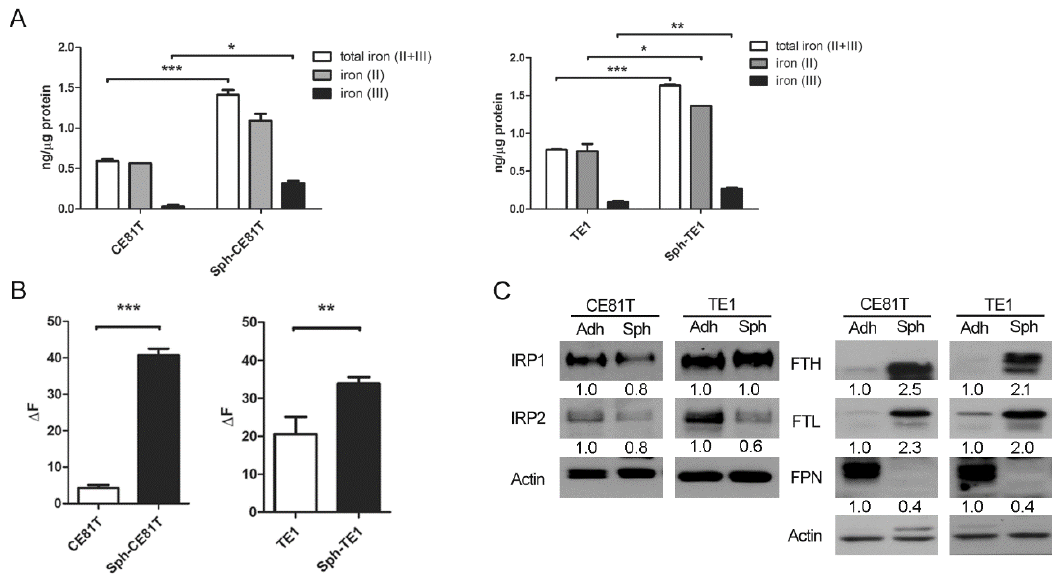
Figure 1. Esophageal cancer cells in spheroid culture have h iron content. ( A ) Total iron assay of esophageal squamous cell carcinoma (ESCC) cells lines, CE81T and TE1, in spheroid (Sph) or adherent (Adh) culture. ( B ) Labile iron pool (LIP) of cells in spheroid and adherent culture. ( C ) Left panel, Western blot analysis with quantification of iron regulatory proteins (IRP) 1 and 2. Right panel, Western blot analysis with quantification of ferritin heavy chain (FTH), ferritin light chain (FTL), and ferroportin (FPN) of cells in spheroid and adherent culture. * p < 0.05, ** p < 0.01, *** p < 0.001 versus control as determined by Student’s t -test.